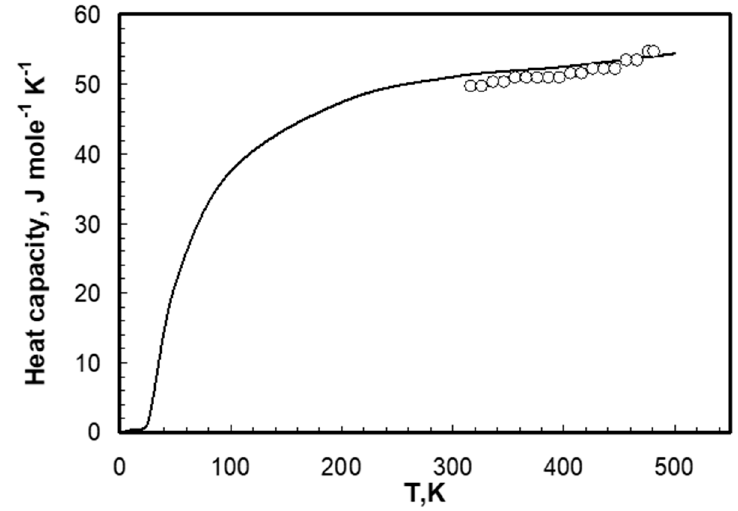
Figure 3. Heat capacity of solid the LiBr-KBr-CsBr eutectic mixture. calculated according to additive law using literature data [8,19]. Table 3. Melting points and enthalpy before the melting of the eutectics. Molar Composition Melting Point, K [1]